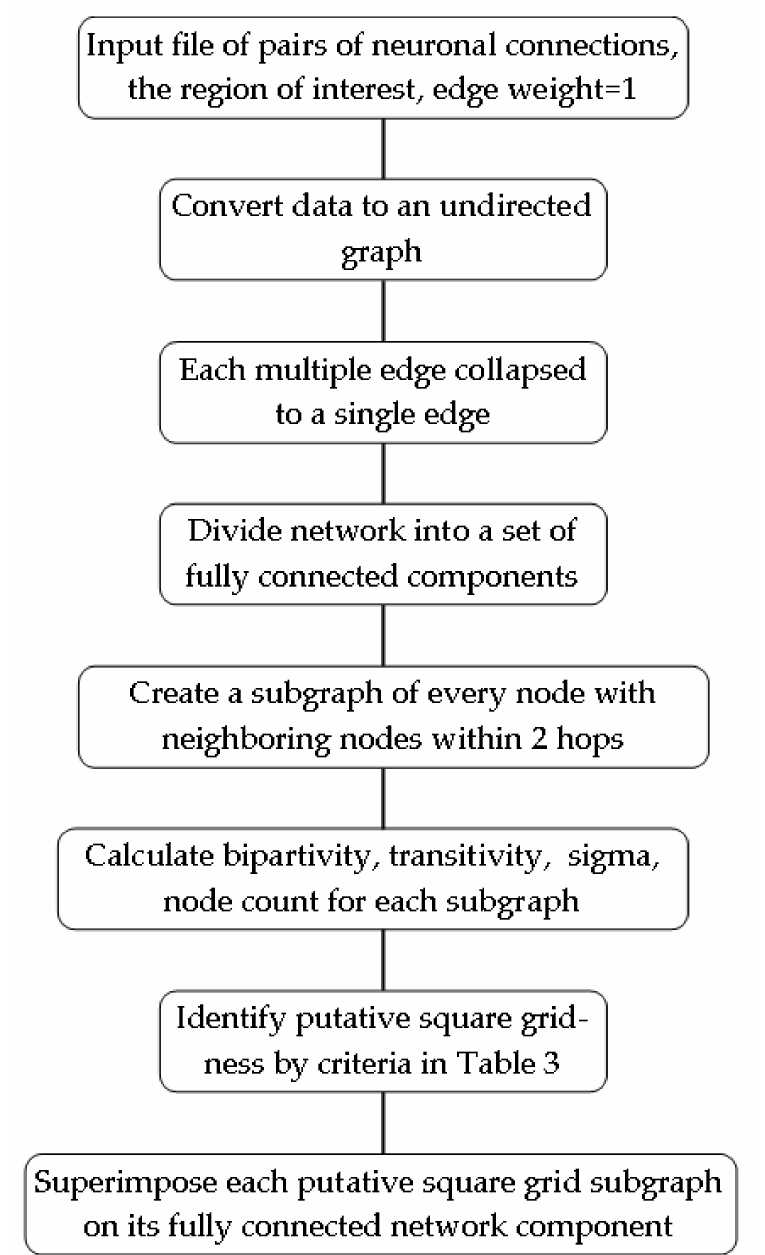
Figure 3. Process for identifying square grid-ness in a network based on neuronal connection